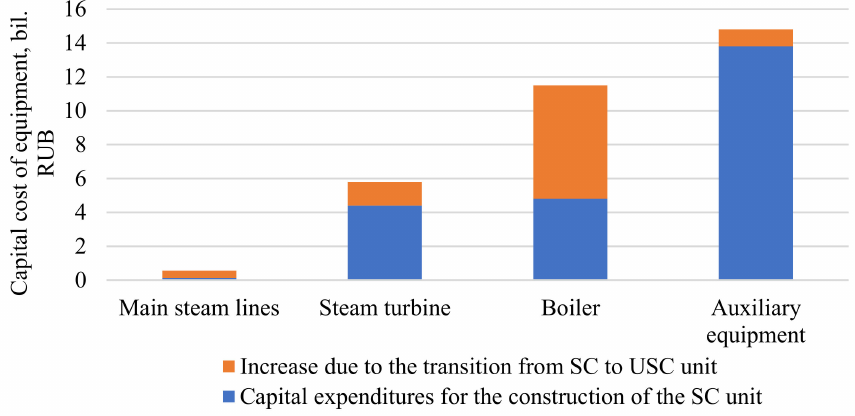
Figure 5. Increase in power facility equipment price caused by the transition to